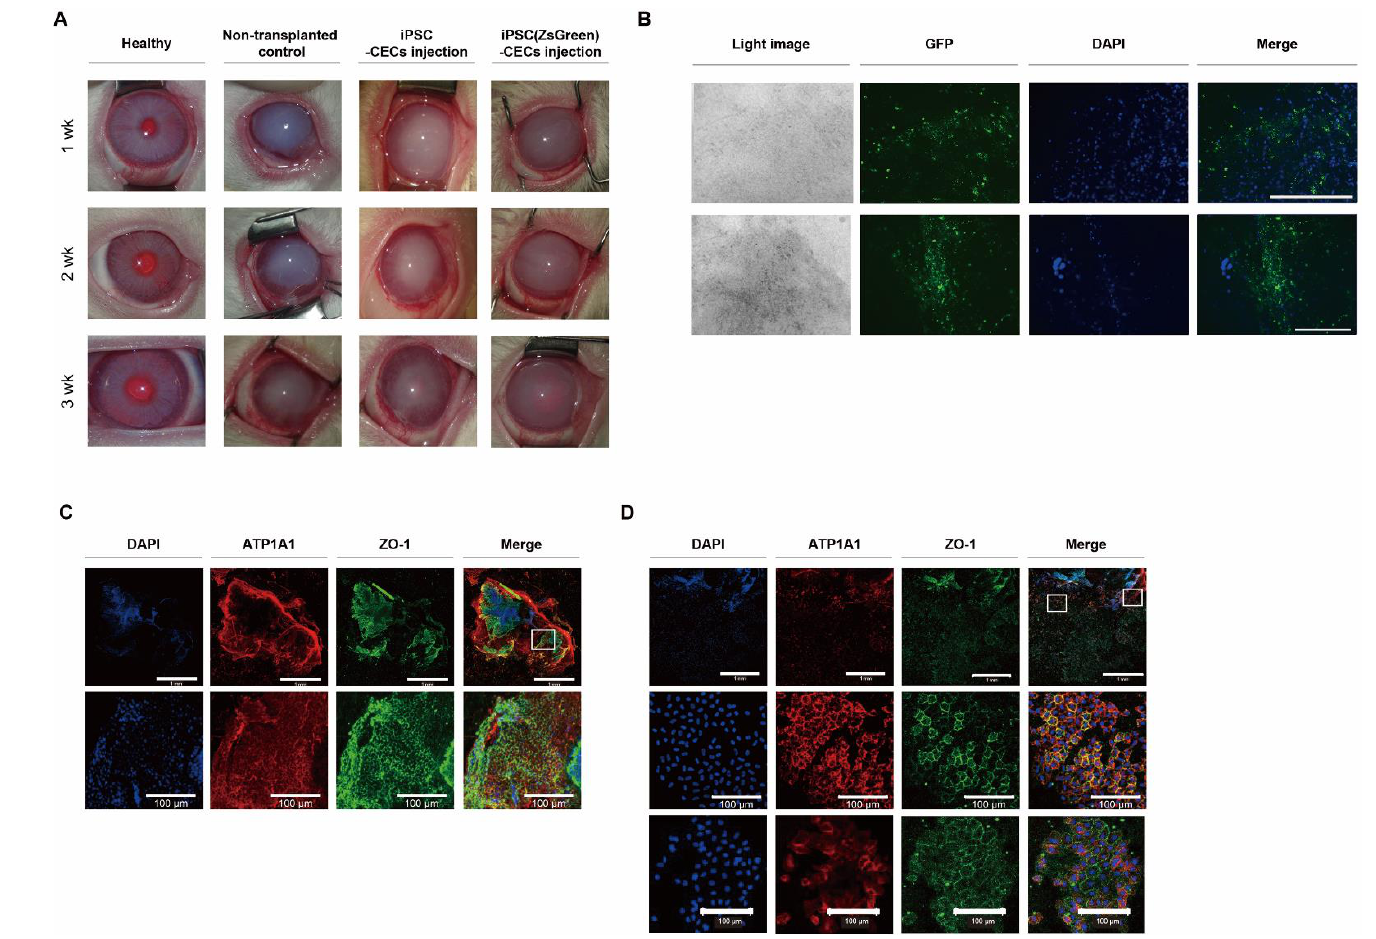
Figure 7. Transplantation of iPSC-induced CECs or iPSC (ZsGreen)-derived CECs produced via a modified protocol (VTN with fasudil) into a corneal endothelial dysfunction rabbit model. ( A ) Ocular observation. ( B ) Observation of transplanted iPSC (ZsGreen)-derived CECs expressing green fluorescent protein and DAPI in the iPSC-derived CEC-transplanted cornea using a fluorescence microscope. Scale bars = 400 μm. ( C , D ) Immunohistochemistry for the detection of human CEC markers (ATP1A1 and ZO-1) in the iPSC-derived CEC-transplanted cornea. ATP1A1 and ZO-1 were broadly expressed in the cornea of the transplant group. ( C , D ) show results in different corneal regions of rabbits after cell transplantation. Higher density with smaller size of transplanted CECs ( C ) and lower density with larger sized cells ( D ) were found in the cornea. The bottom rows show higher magnifications of images of the white rectangles in the top row. Scale bars = 1 mm or 100 μm.